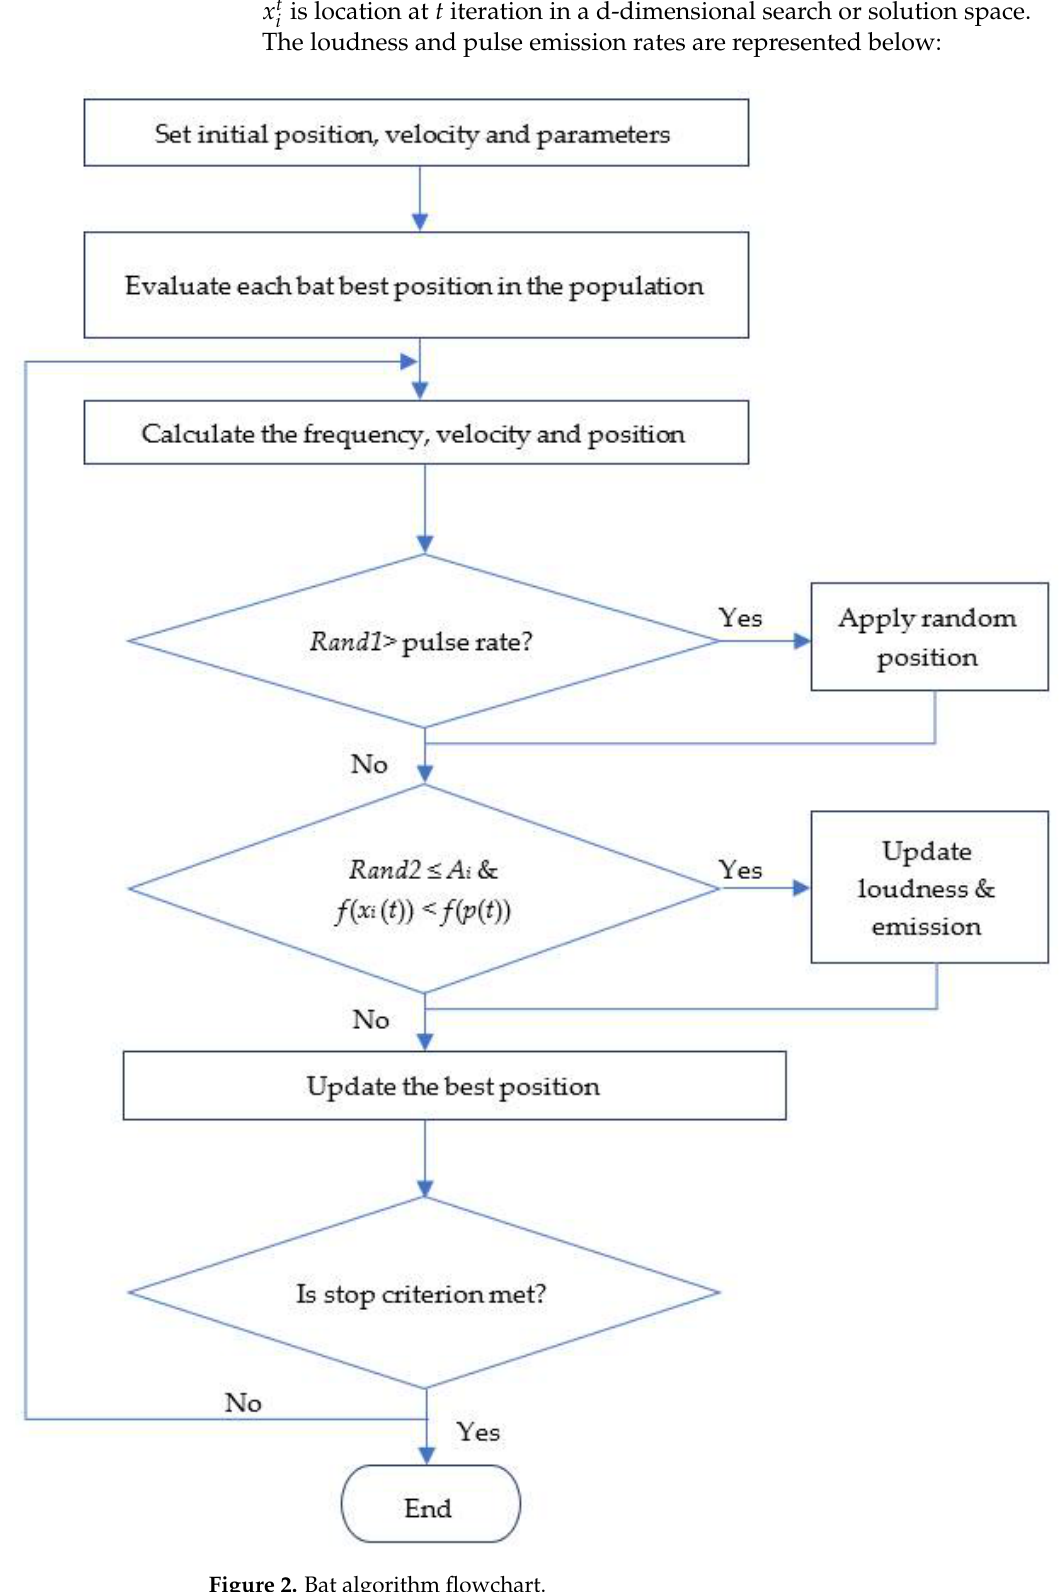
Figure 2. Bat algorithm flowchart.